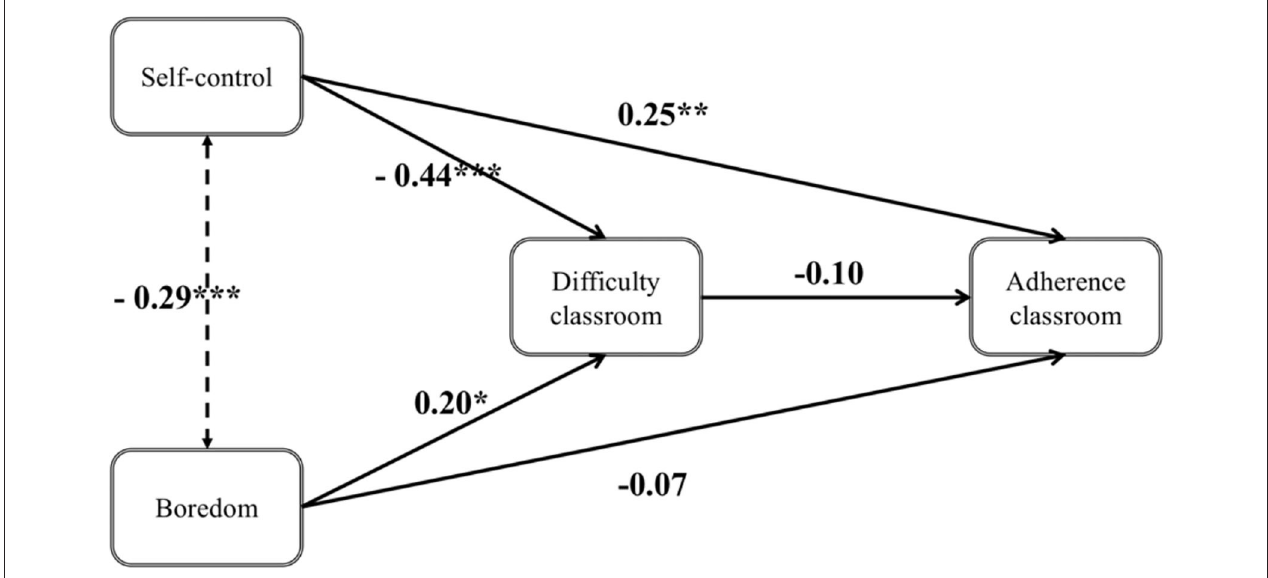
FIGURE 3 | Classroom model N = 138. Coefficients are unstandardized ***. Difference is significant at the 0.001 level (two-tailed) and **. Difference is significant at the 0.01 level (two-tailed).